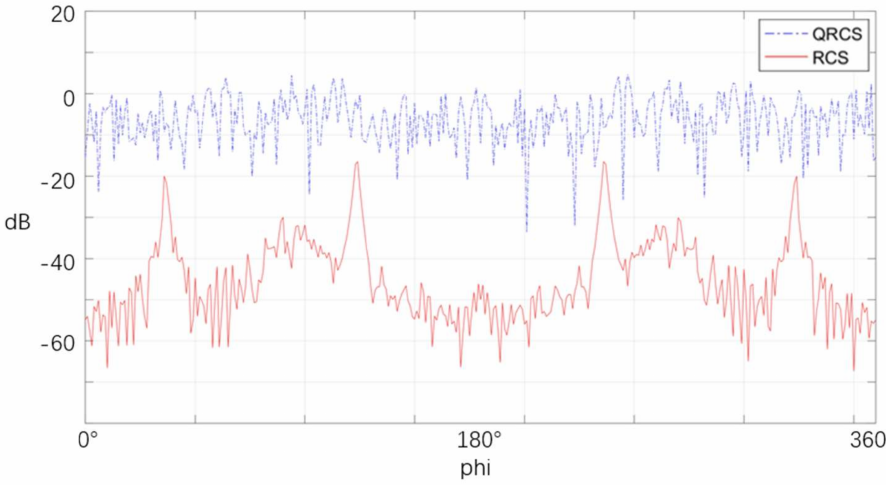
Figure 16. RCS and QRCS of the flying-wing stealth aircraft at various azimuth angles without pitch